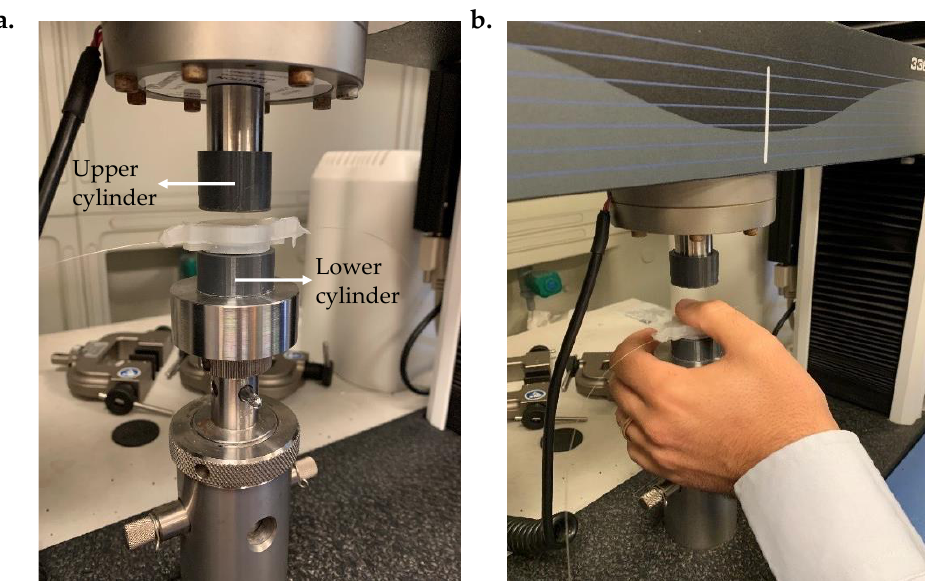
Figure 3. Configurations of the compression tests carried out for all SSs developed (for each Dragon Skin TM and thickness) in the absence (SS accommodated between the two PLA cylinders) ( a ) and in the presence ( b ) of a volunteer thumb between the upper cylinder and the SS.